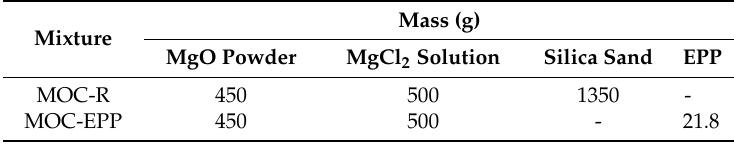
Table 3. Mix proportions of MOC-based composites.